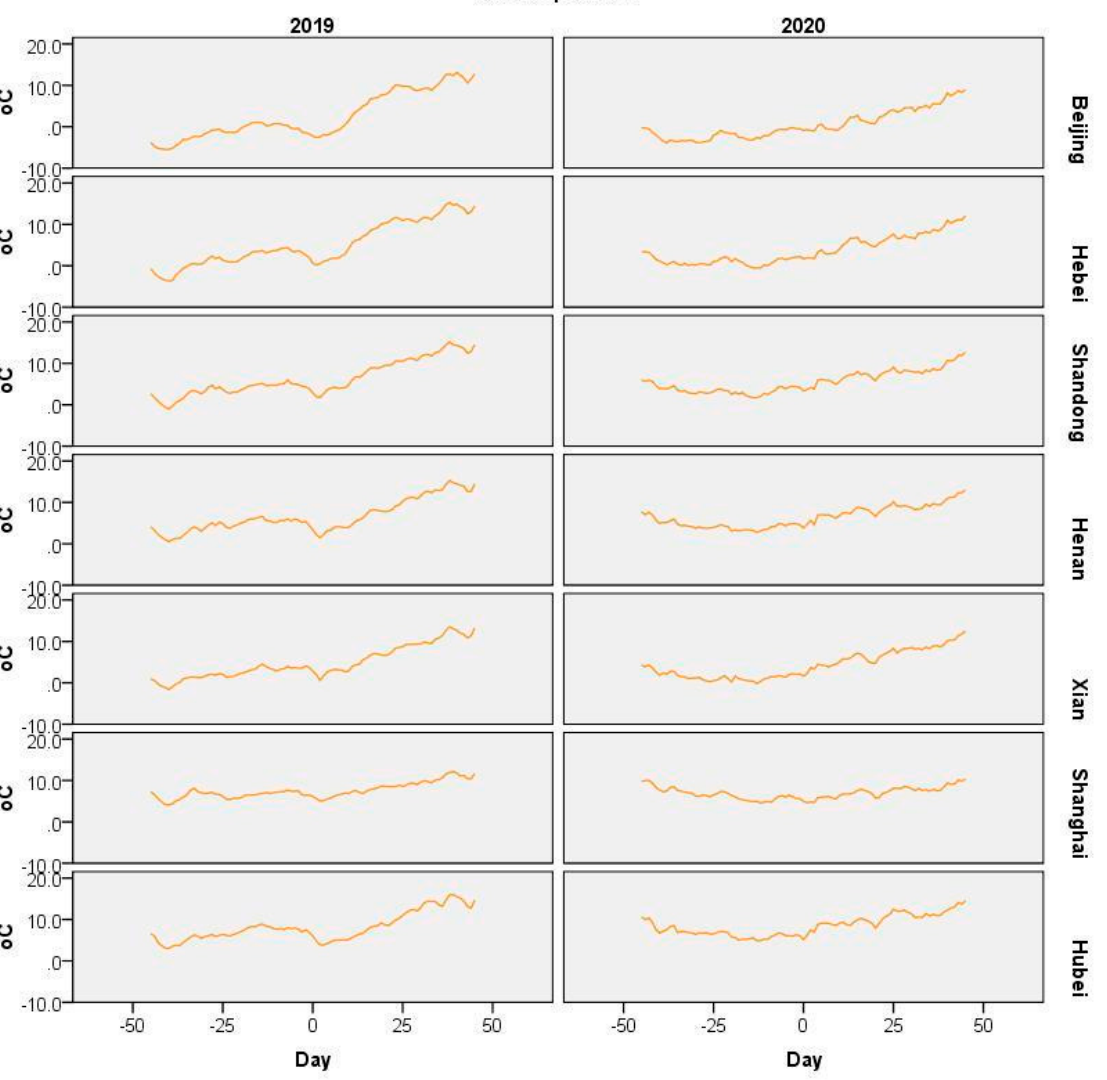
Figure A3. Daily time series of air temperature during equivalent 91-day timeframes of investigation for 2019 and 2020, across seven regions of China.